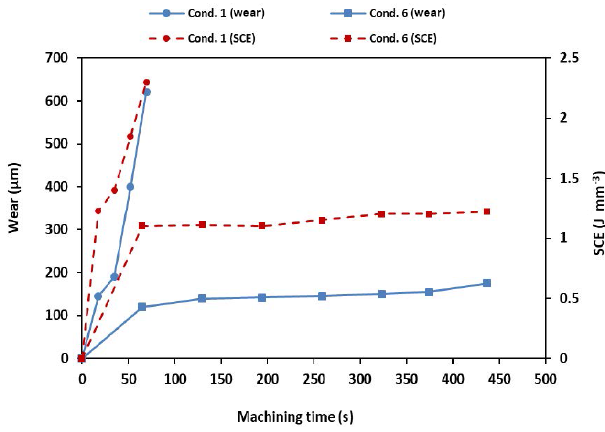
Figure 11. Temperature variation with increasing the cutting speeds (Fan et al., 2016). Figure 12. The variation in flank wear and SCE with an increase in cutting speed (Cond. 1 and Cond. 6).